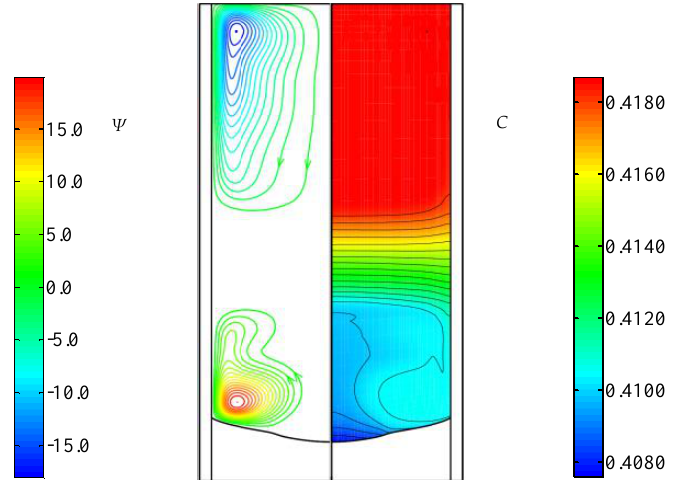
Figure 2. Flow ( Ψ (mm 3 /s)) and concentration ( C ) fields at t = 20 h without the ACRT. The left side represents the contours of the stream function in the solution region, where the flow direction is indicated by the arrows, and the right side represents the concentration field of ZnTe. The positive and negative values of Ψ represent the counterclockwise and clockwise flows, respectively.